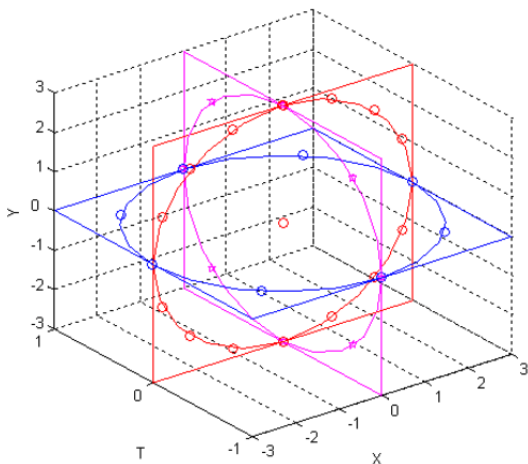
Figure 3. Visual representation of a TOP-LBP example: each ellipsoid shows a planar LBP calculated on a specific orthogonal